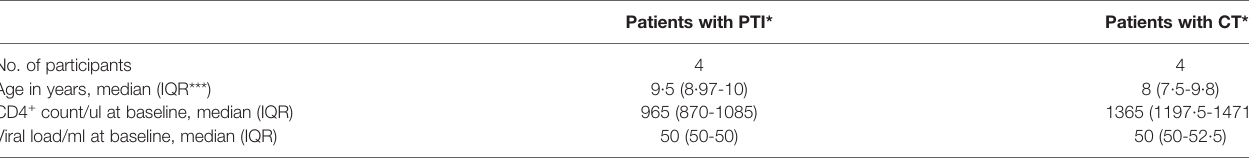
TABLE 1 | Patient Characteristics.